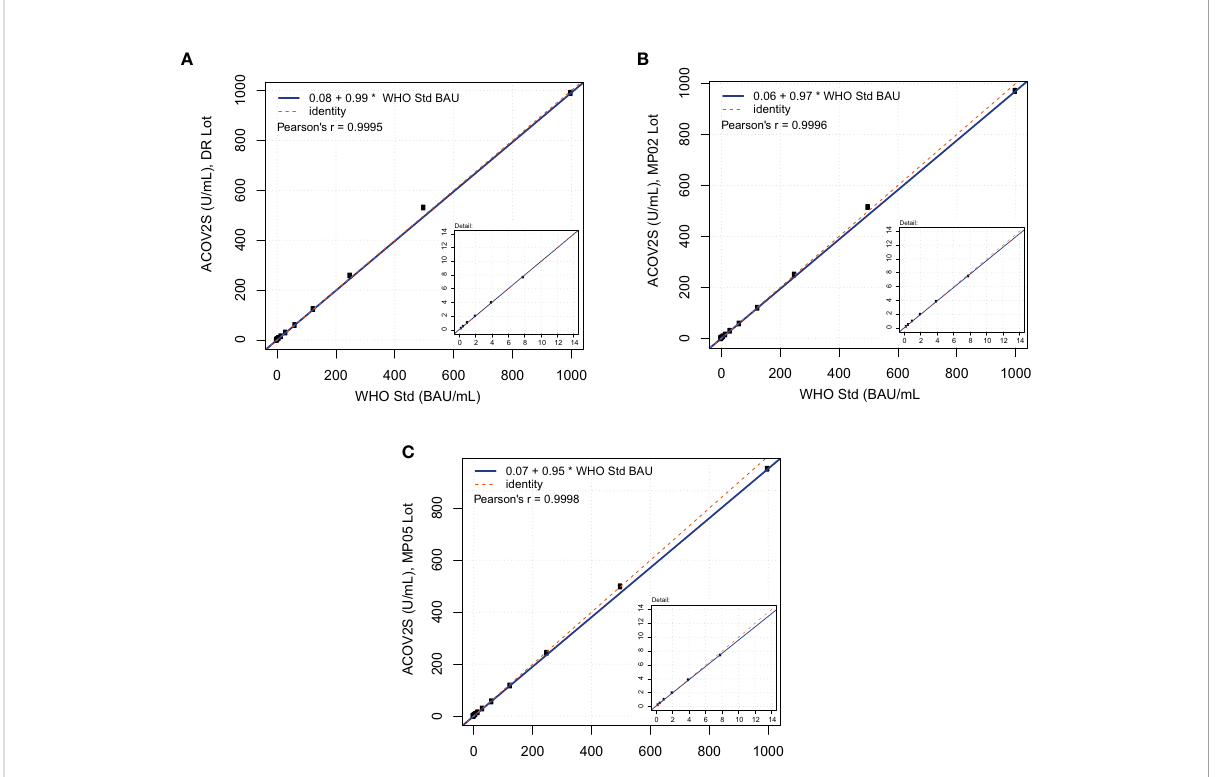
FIGURE 2 Correlation of ACOV2S units to the First International WHO Standard for anti-SARS-CoV-2 immunoglobulins. Linearity using a dilution series of the WHO standard for (A) lot DR, (B) lot MP02, and (C) lot